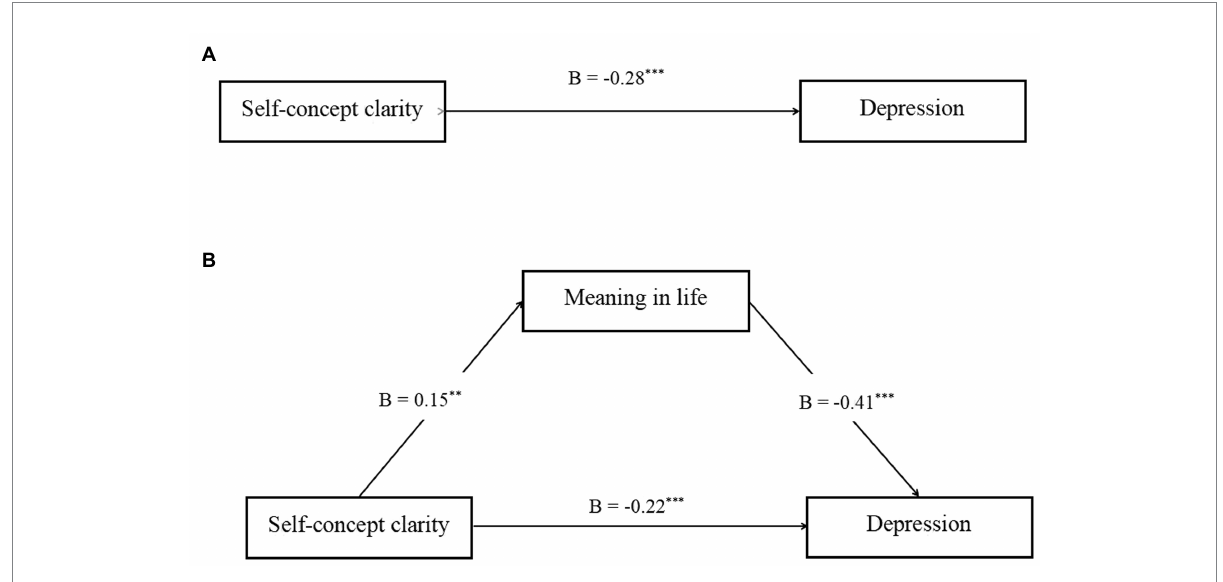
FIGURE 2 Mediator model depicting direct and indirect effects of self-concept clarity on depression tested in the current study. Graphic (A) depicts the total effect of self-concept clarity on depression. Graphic (B) depicts the direct effect of self-concept clarity on depression after including mediators.